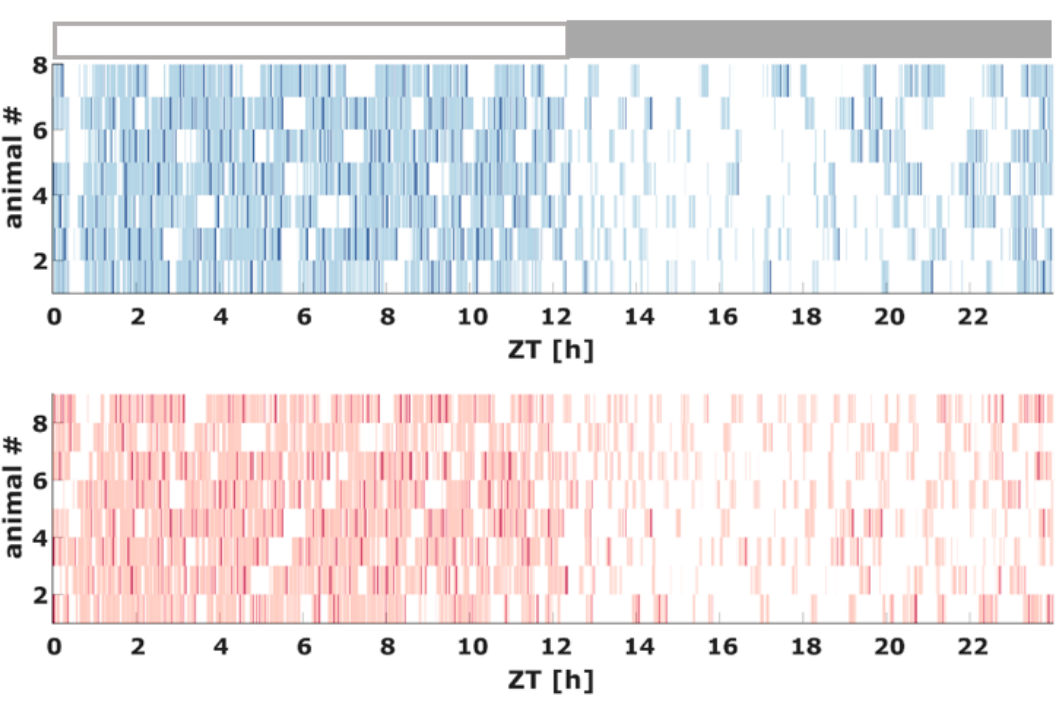
Figure 1. Hypnogram of the AC (top) and AD (bottom) animals over the entire 24 h observation period derived from the 10 s scoring with lights turned off after the 12th hour. White indicates WAKE, light blue (AC) or light red (AD) indicates NREM, and blue (AC) or red (AB) indicates REM. The x-axis is Zeitgeber time (ZT) with ZT = 0 indicating the start of the inactive “lights-on” phase at 7 am. The grey rectangle indicates the active “lights-off” phase. #: number